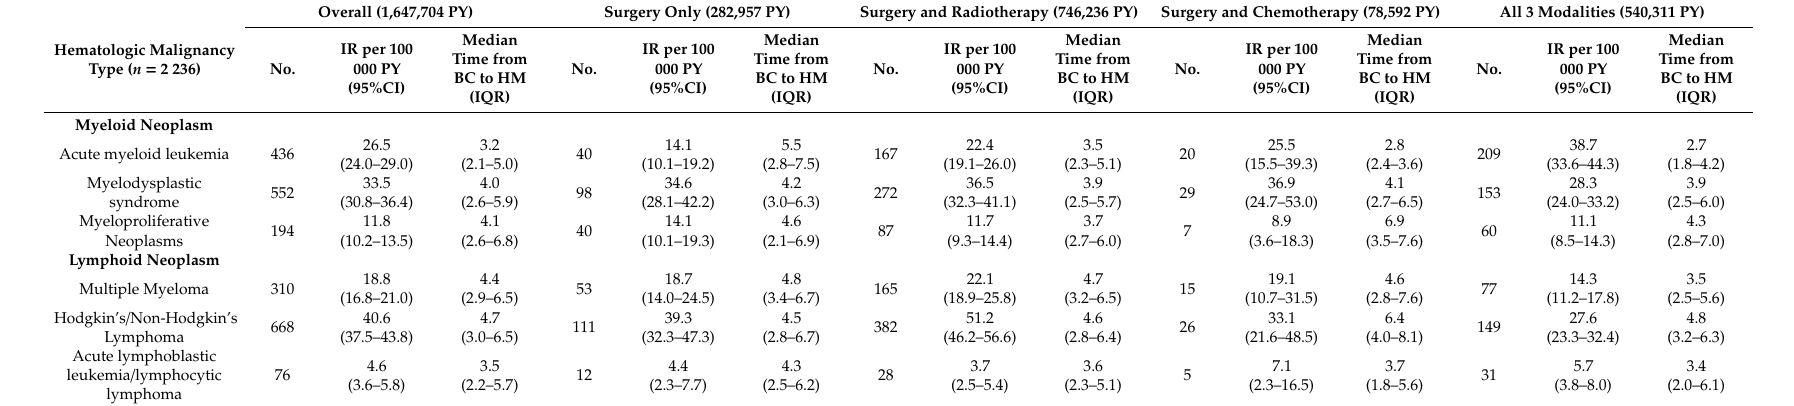
Table 2. Incidence of hematologic malignancies according to exposure